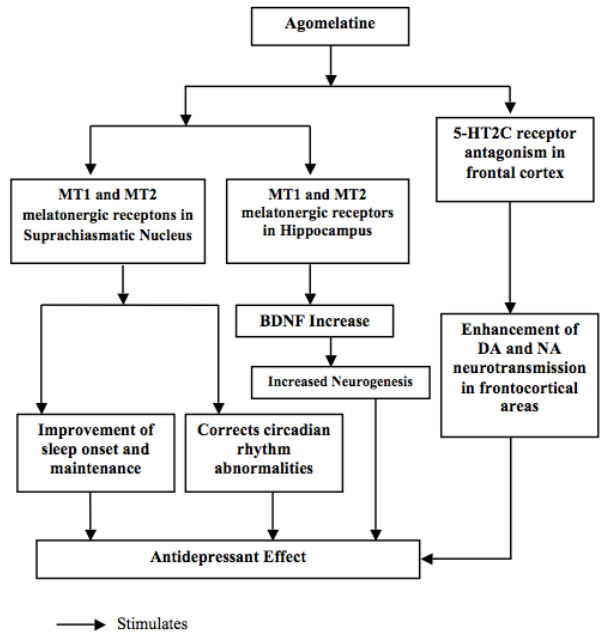
Figure 1. Mechanism of action of agomelatine (adapted from Srinivasan et al.